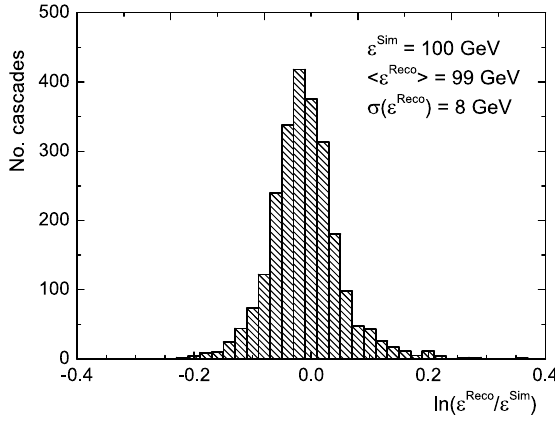
Figure 6. Distribution of cascades in the ( ε Reco /ε Sim